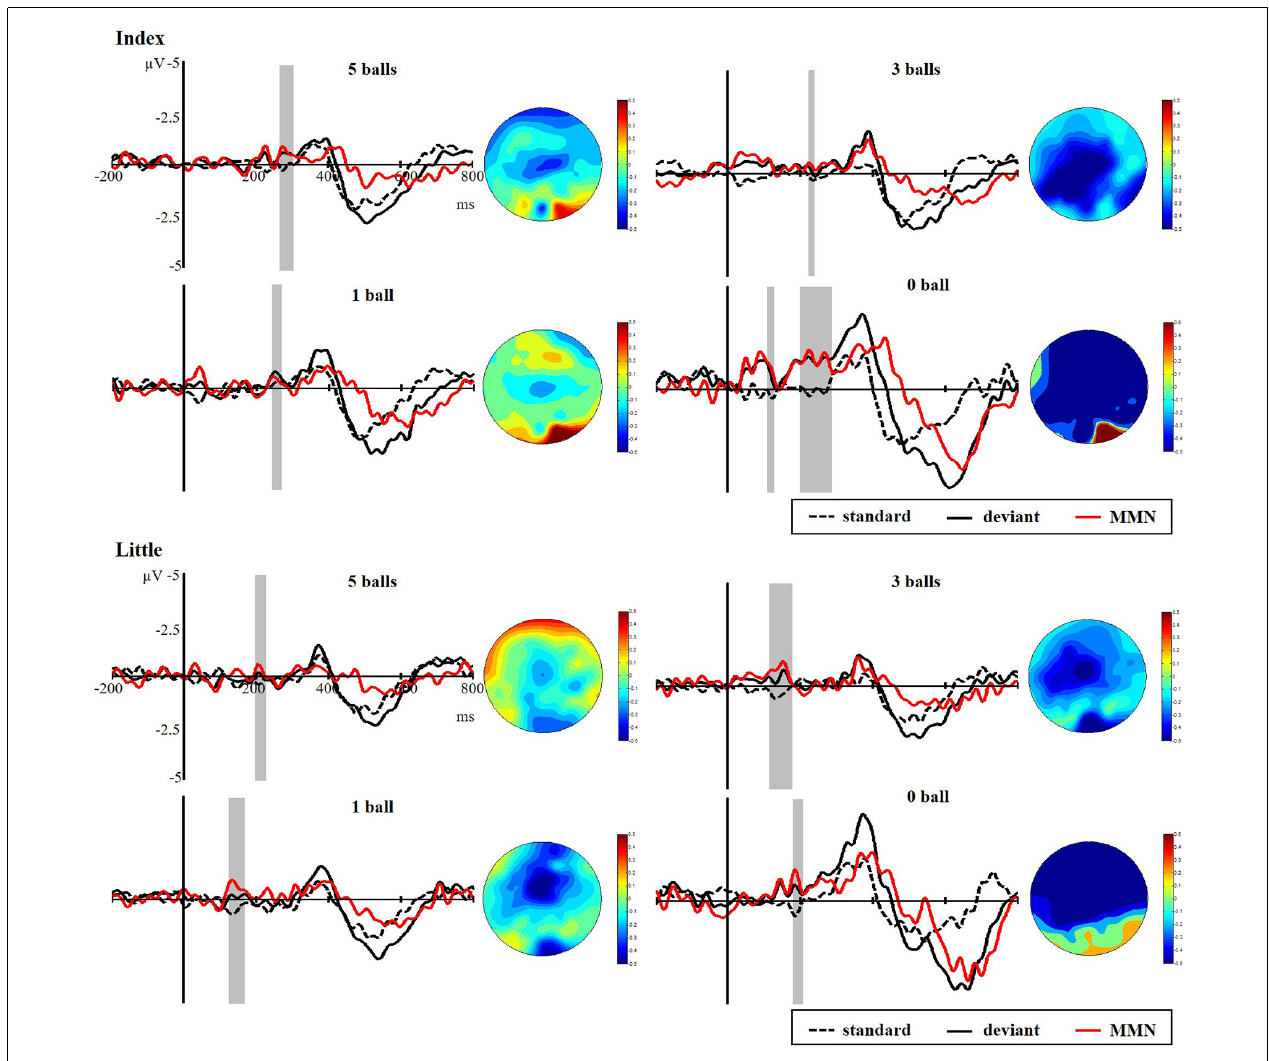
FIGURE 8 | Grand average ERPs of standard (dotted line) and deviant (solid line) stimuli at the FC4 electrode site. The sMMN (red line) was obtained by subtracting the waveforms of the standard stimuli from waveforms of the deviant stimuli. The gray area superimposes on the waveform represent the time window of sMMN, showing the significant difference between standard and deviant stimuli as revealed by the point-wise paired t -tests. Scalp topographic distributions are shown beside the waveforms of ERPs with time windows of 100–300